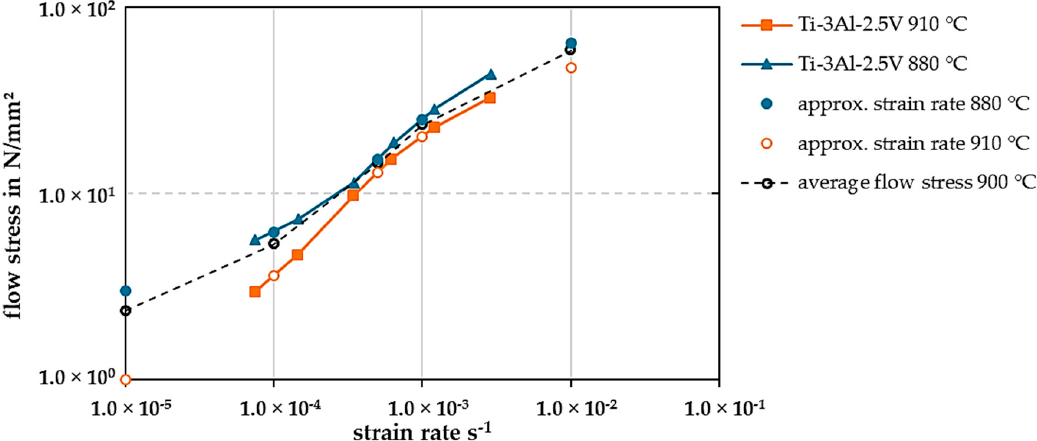
Figure 3. Flow stress-strain rate diagram for Ti-3Al-2.5V according to [15,36] and derived values for the 900 °C forming temperature.